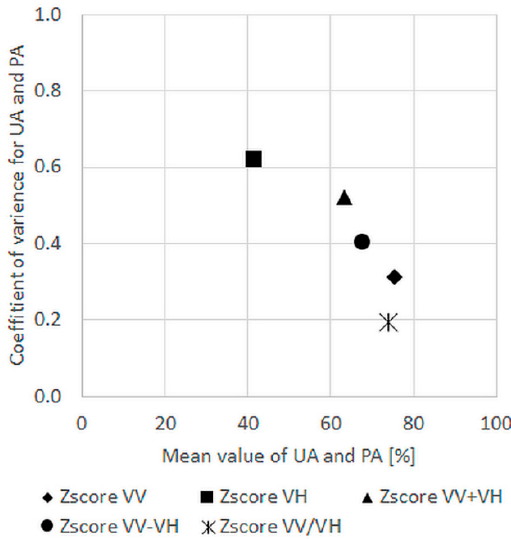
Figure 14. Comparison of object-based time series features as a function of mean value and coefficient of variation. The statistical values (mean value and coefficient of variance) were calculated on the basis of the PA and UA accuracy values.